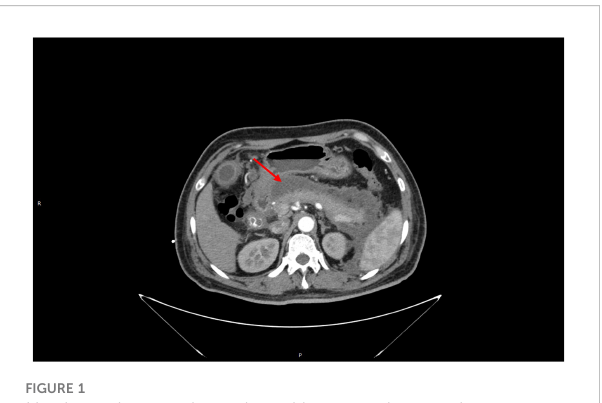
FIGURE 1 Massive peripancreatic exudate with pancreatic